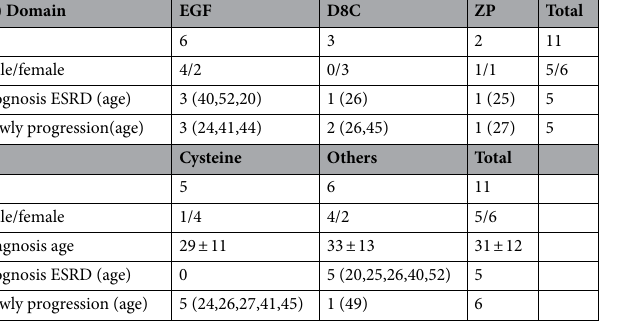
Table 3. Renal survival of ADTKD-UMOD patients classified by UMOD domain or cysteine substitution. ADTKD autosomal dominant tubulointerstitial kidney disease, NOS not otherwise specified, ESRD end stage renal disease, EGF epidermal growth factor, ZP zona pellucida. A. Renal survival of ADTKD-UMOD patients classified by UMOD domain. The prognosis was analyzed by Kaplan–Meier analysis, with p > 0.05. B. Renal survival for ADTKD-UMOD patients classified by cysteine substitution. Diagnosis age did not statistically differ between the two groups. (p = 0.632) The prognosis was analyzed by Kaplan–Meier analysis, with P = 0.015. ESRD end stage renal